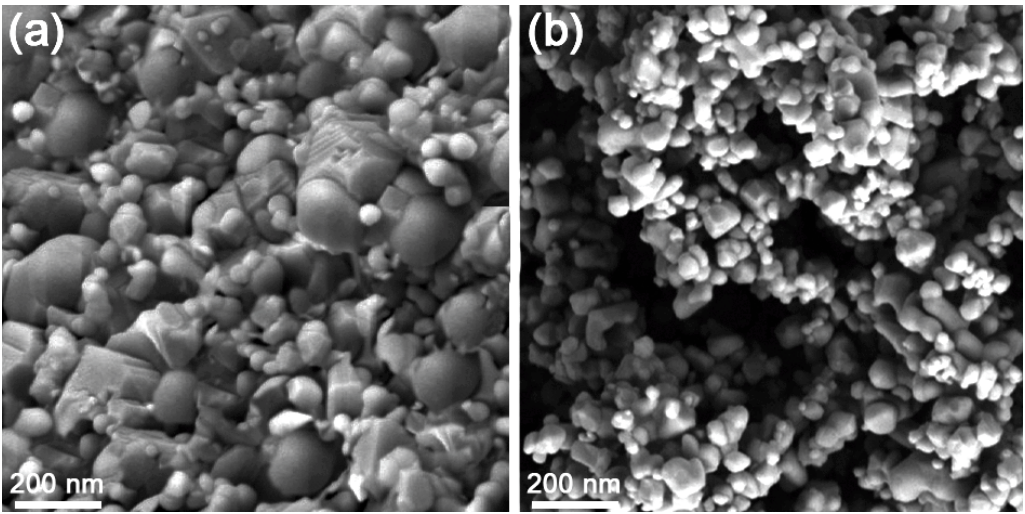
Figure 1. SEM images: ( a ) as-prepared sample CTO as ; ( b ) annealed sample CTO ann .